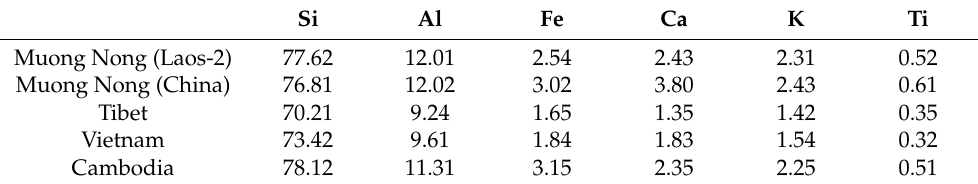
Table 7. Average major elements chemical composition (wt.%) of Australasian tektites determined from XRF by the second method using SEA6000 instrument. The method does not allow the determi- nation of Na and Mg contents. The error in the values is 2%. Si